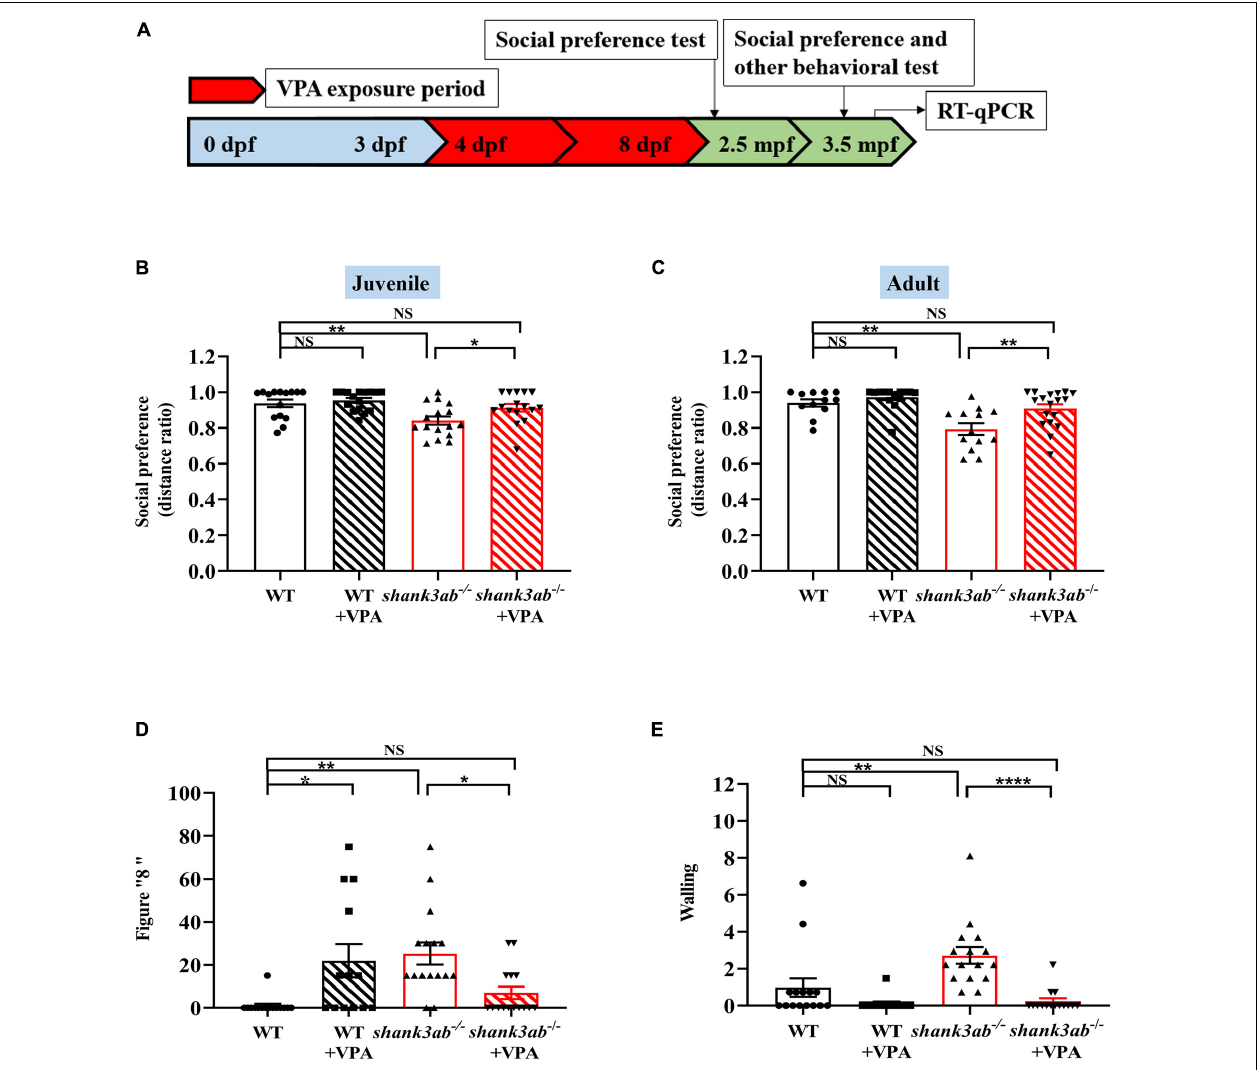
FIGURE 5 | Improved ASD core symptoms in shank3 -deficient zebrafish upon early VPA treatment. (A) Schematic overview of the protocol used for the VPA exposure period, the evaluation of behavioral tests at juvenile (2.5 mpf) and adult (3.5 mpf), and RT-qPCR analysis at 4.5 mpf. Red color indicates the VPA exposure phases. (B) Social preference index (distance ratio) of social test on juvenile zebrafish, WT, n = 15; WT-VPA, n = 16; shank3ab - / - , n = 16; shank3ab - / - -VPA, n = 16. (C) Social preference index (distance ratio) of social test on adult zebrafish, WT, n = 12; WT-VPA, n = 14; shank3ab - / - , n = 13; shank3ab - / - -VPA, n = 18. (D) The VPA treatment reduced abnormal proportion of stereotypic figure “8” swimming and (E) back and forth swimming (walling) in shank3ab - / - zebrafish, WT, n = 15; WT-VPA, n = 13; shank3ab - / - , n = 16; shank3ab - / - -VPA, n = 15. Data are shown as mean ± SEM. Statistical analyses: (B) one-way ANOVA with LSD correction